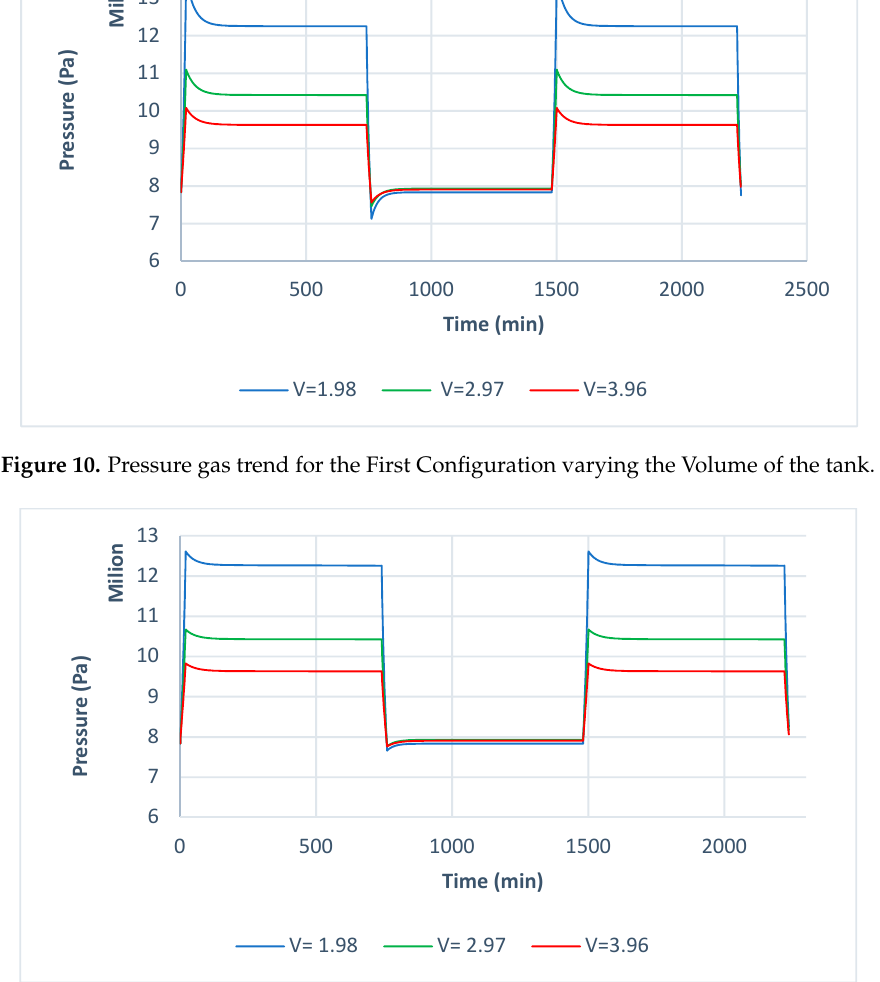
Figure 11. Pressure gas trend for the Second Configuration varying the Volume of the tank.